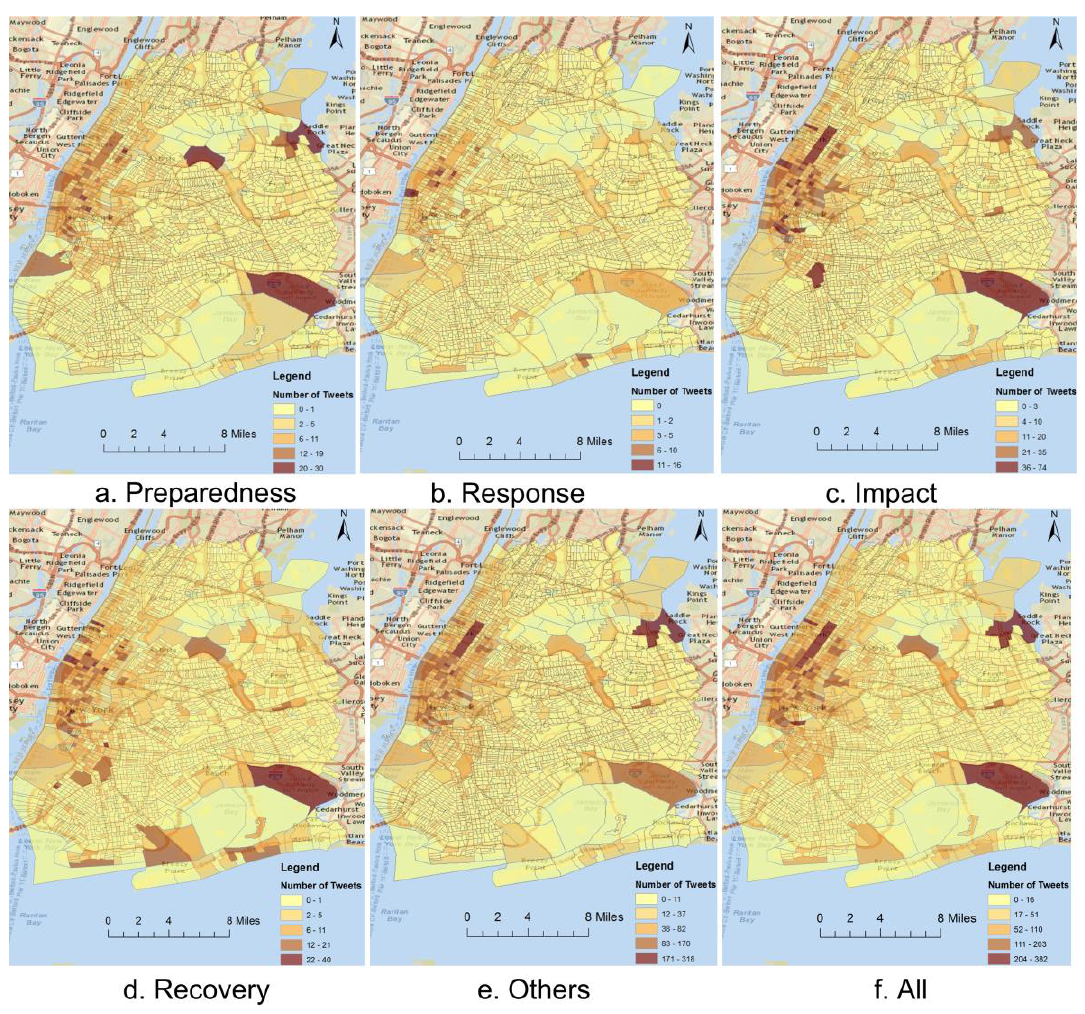
Figure 3. The geographical distribution of disaster-relevant tweets within different disaster